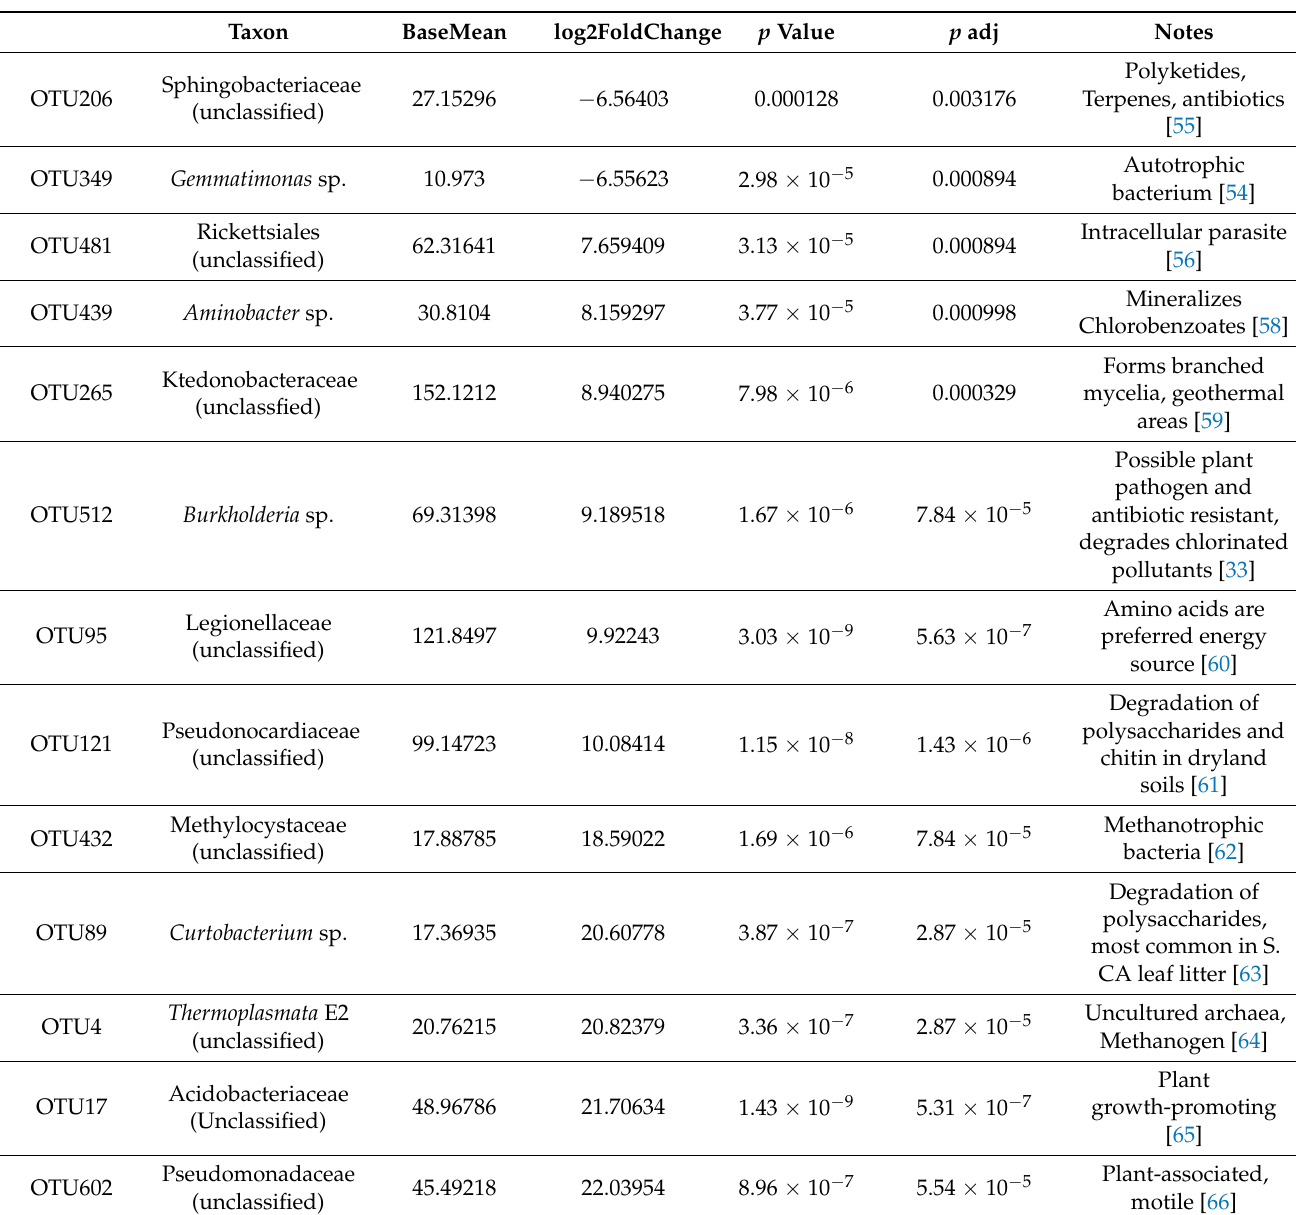
Table 8. Red Trail vs. Blue Trail 16S Round 2 differential abundance analysis. Taxa with negative fold change values were elevated on the Blue Trail. Taxa with positive fold change values were elevated on the Red Trail.